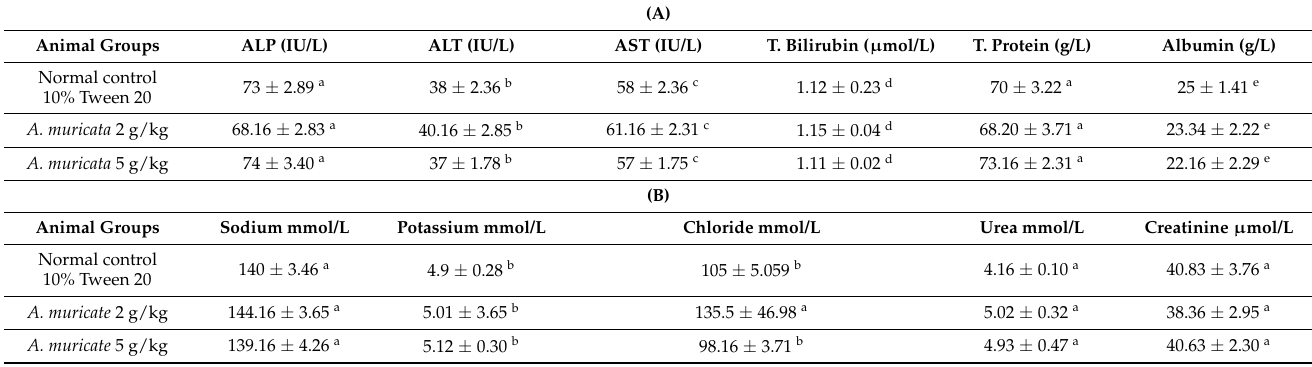
Table 1. ( A ) Acute toxicity test: Influences of Annona muricata extract on liver biochemical markers in rats. ( B ) Acute toxicity test: Effects of Annona muricata extract on kidney biochemical parameters in